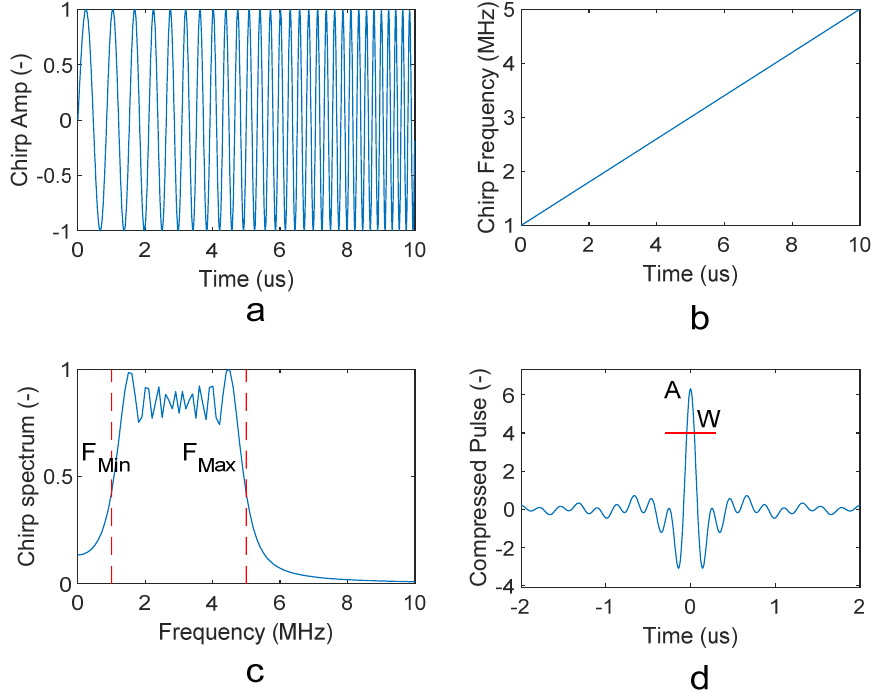
Figure 1. Example of chirp with T = 10 μ s, B = 4 MHz, BT = 40 and its compressed pulse. ( a ) Chirp signal; ( b ) instantaneous frequency of the chirp; ( c ) spectrum of the chirp; ( d ) compressed pulse with − 4 dB width W = 0.25 μ s and amplitude gain A = 6.3.